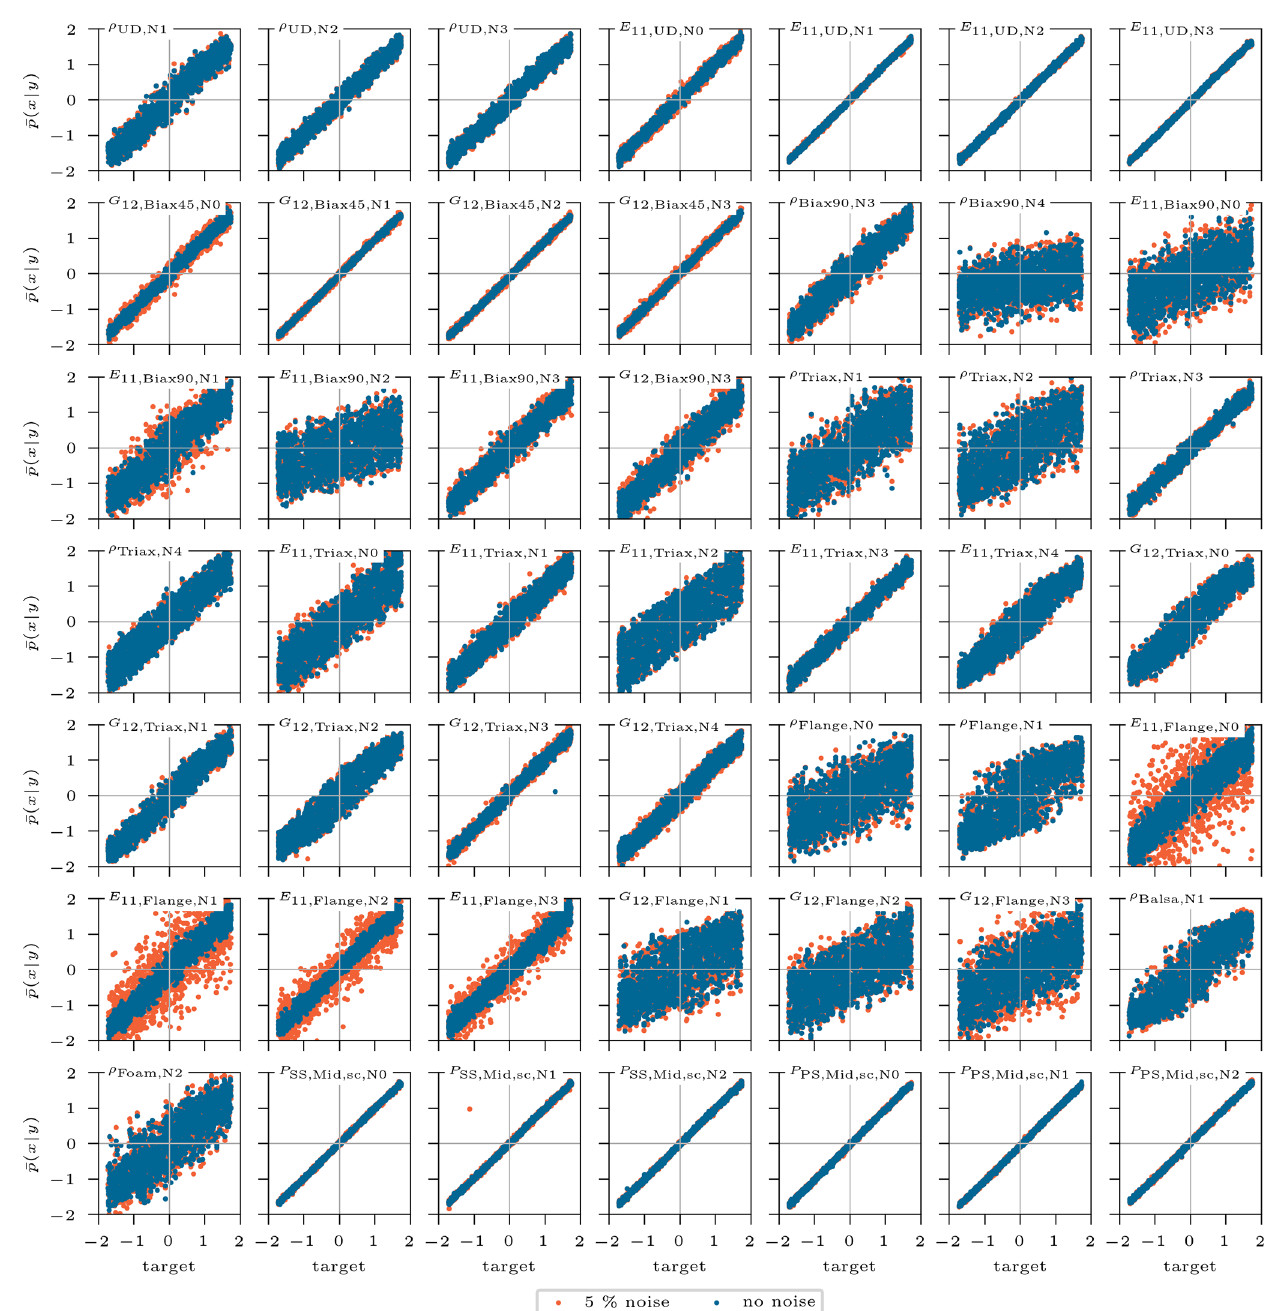
Figure A1. Standardized mean of posterior prediction x of the updated inputs over the corresponding target standardized value for the 5000 test samples. The original samples predicted with clean conditions are in blue, compared to samples with noisy flawed conditions (5% random noise) in orange. The noisy conditions are intended to simulate measurement inaccuracies of the modal beam response.